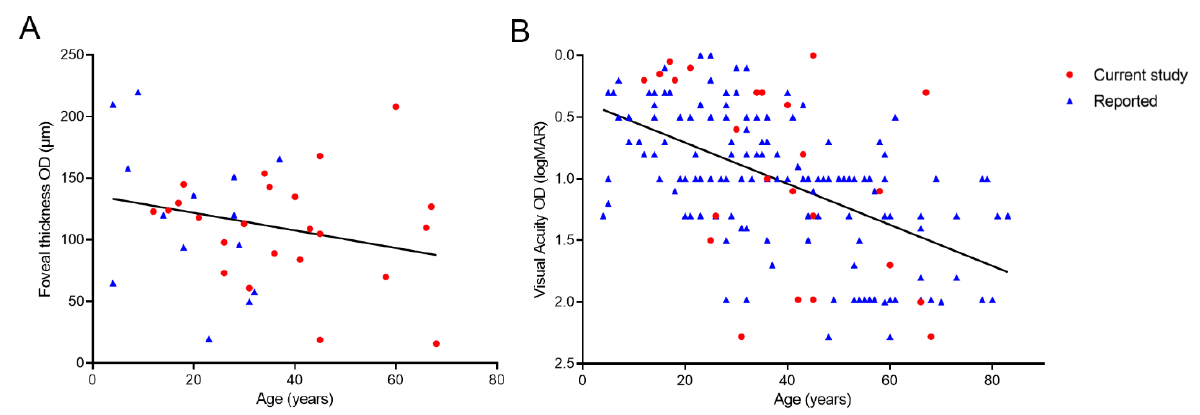
Figure 4. A ) Linear regression of foveal thickness (OD) associated with age ( n = 38). B ) Linear re- gression of visual acuity values (OD) associated with age in GUCY2D -related AD COD/CORD pa- tients ( n = 170).